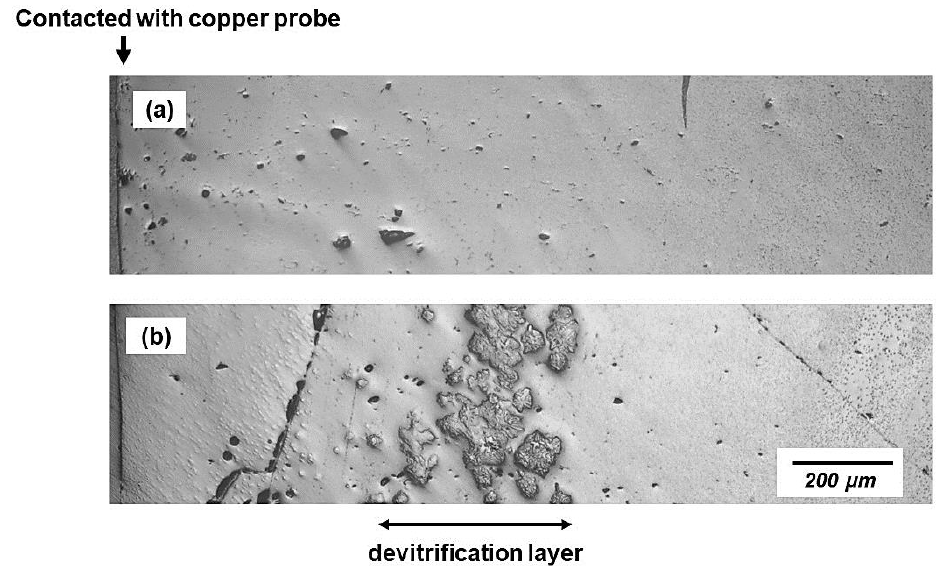
Figure 2. Optical images of cross-sections of solid slag films with different solidification times, ( a ) 15 s, ( b ) 30 s of No. 1 slag (bulk temperature 1300 °C).